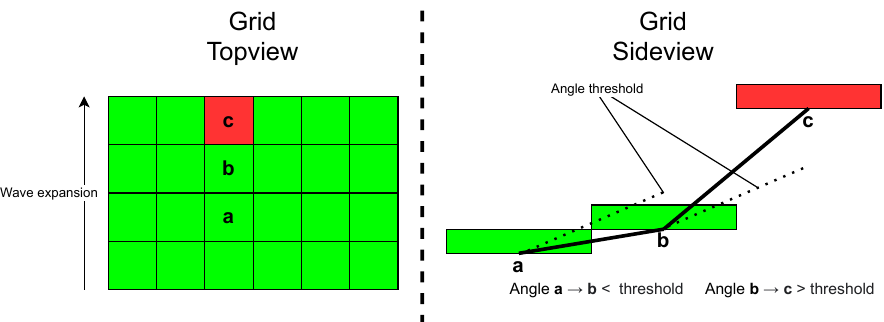
Figure 5. Ray-based ground–object segmentation detection functionality, sketch. The angle between cell a and b does not exceed the threshold, cell b is marked as ground cell. The angle between cell b and c exceeds the threshold, cell c is marked as